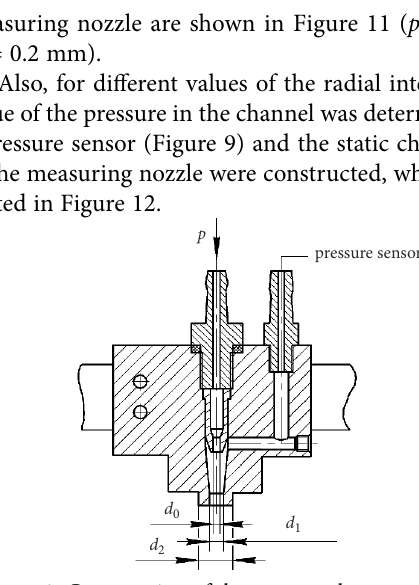
Figure 9. Construction of the antenna shape control sensor: d 0 – diameter of the active nozzle; d 1 – inner diameter of the measuring nozzle; d 2 – outer diameter of the measuring nozzle